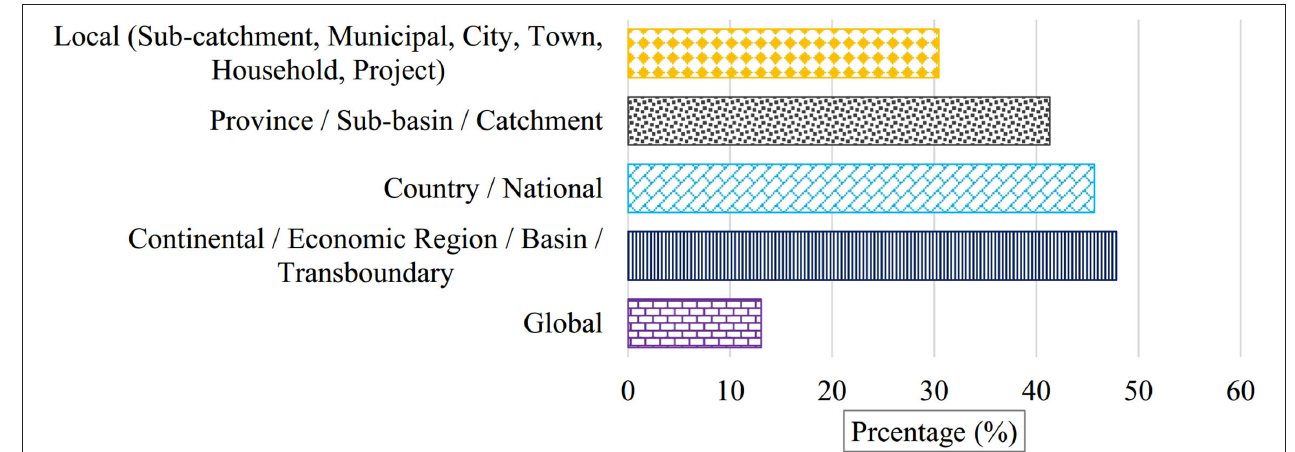
FIGURE 7 | Spatial scales of application of documented WEF nexus